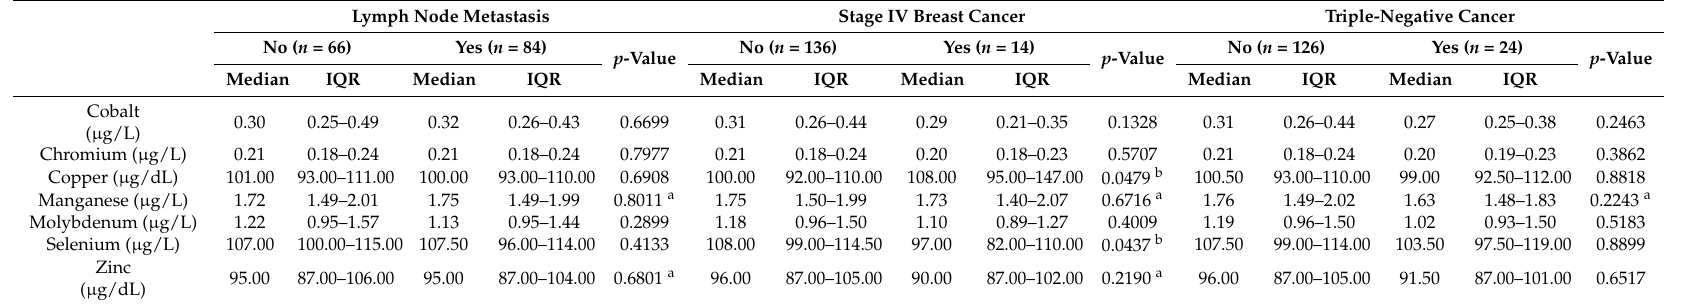
Table 2. Subgroup analyses for seven trace elements in 150 breast cancer patients in the discovery